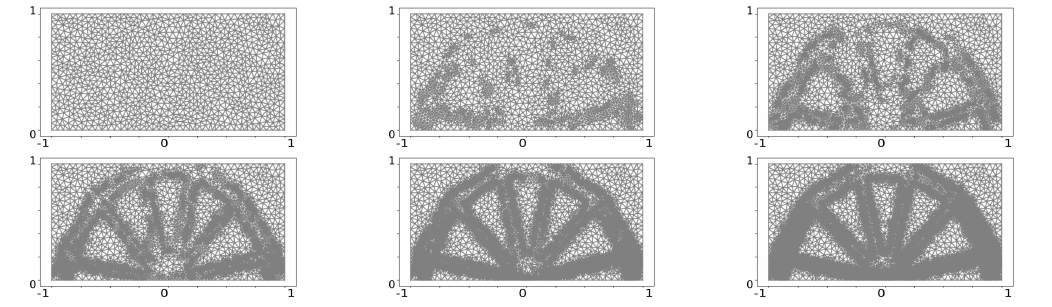
Figure A4. Iteration of adaptive mesh T m from Appendix A.1.